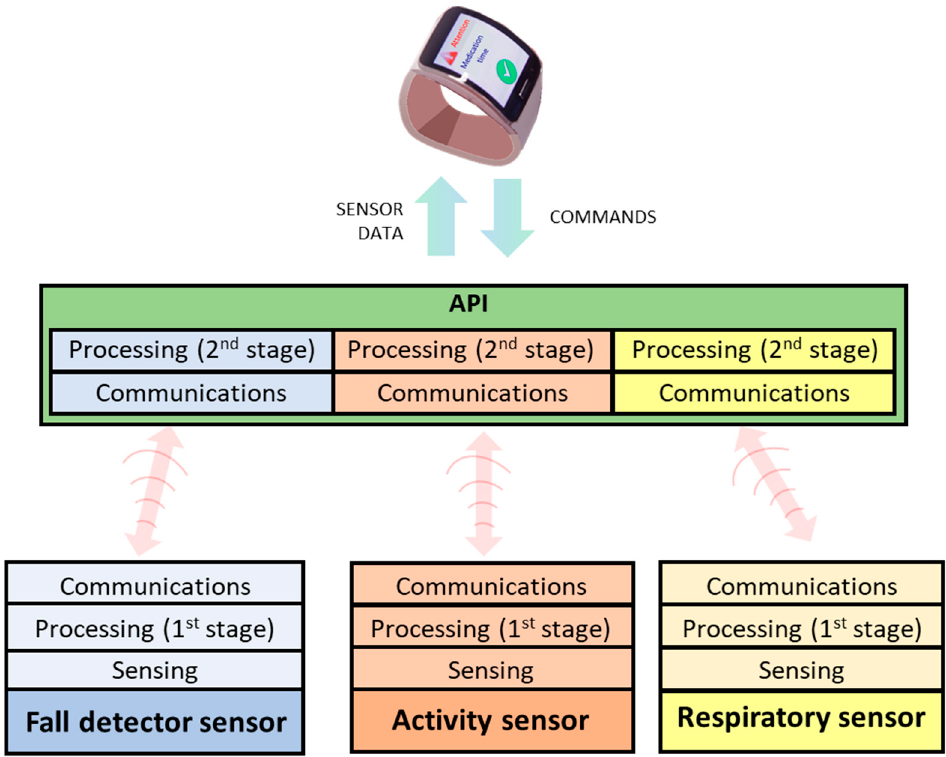
Figure 8. Communication model between sensors and smartwatch through API. Table 2. API personalization